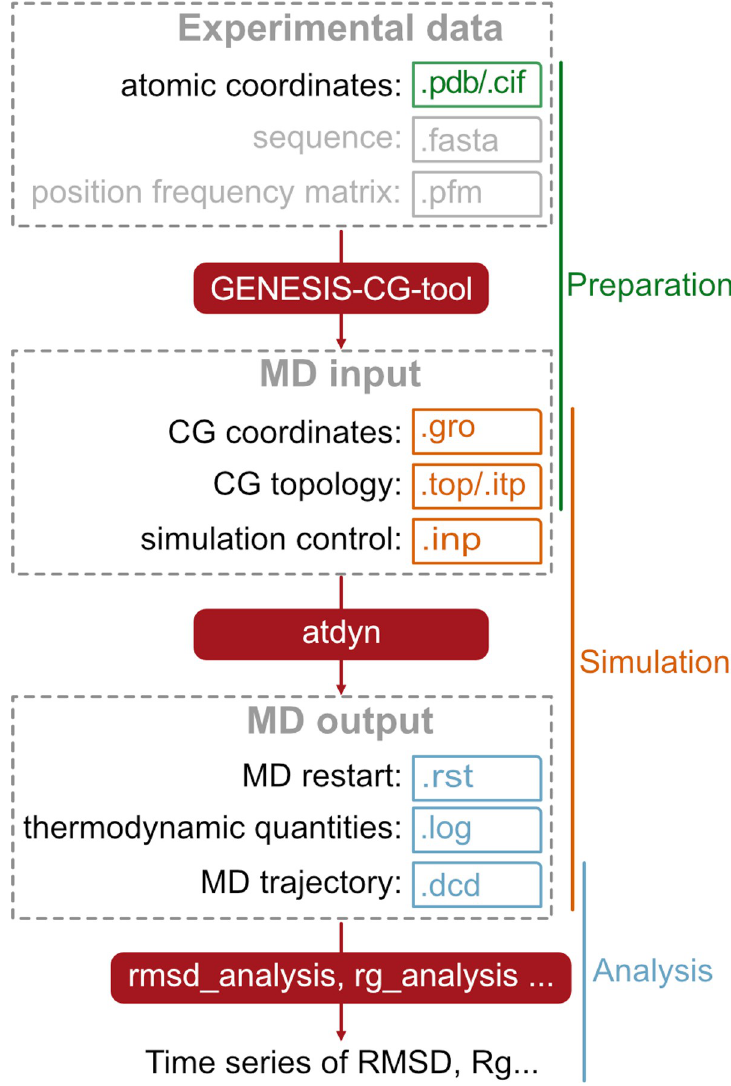
Fig 2. Information flow in GENESIS CG MD simulations. Dashed boxes represent collections of files used together as input or output at a particular step. Solid red boxes are used for the executable tools provided by GENESIS. Small boxes include typical filename